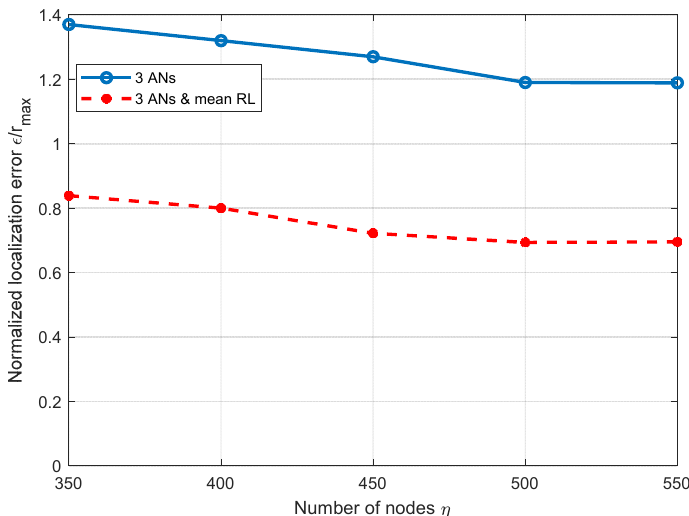
Figure 11. Normalized mean squared error ε / r max vs. number of nodes η for multihop scenarios, r max = 3 m.